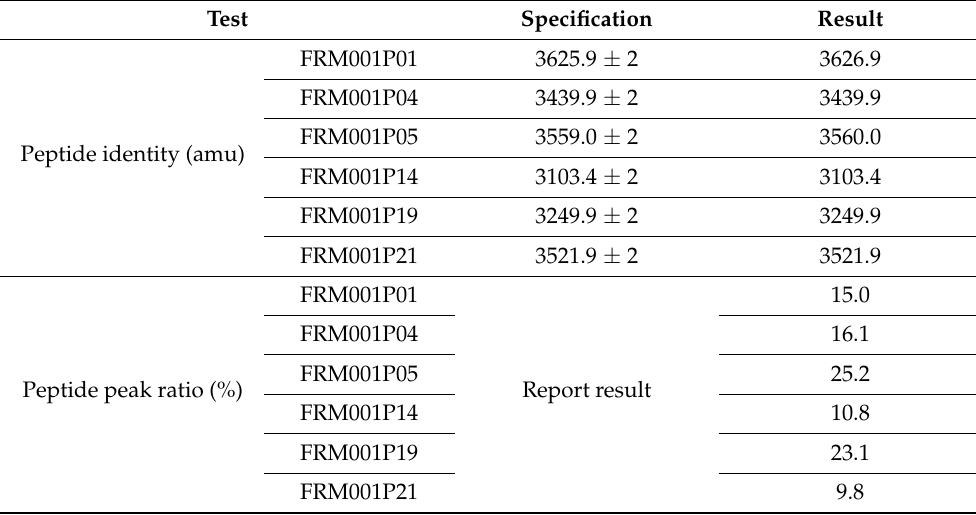
Table 4. The tests results of peptide mixture FRM001-M1 that was manufactured under GMP